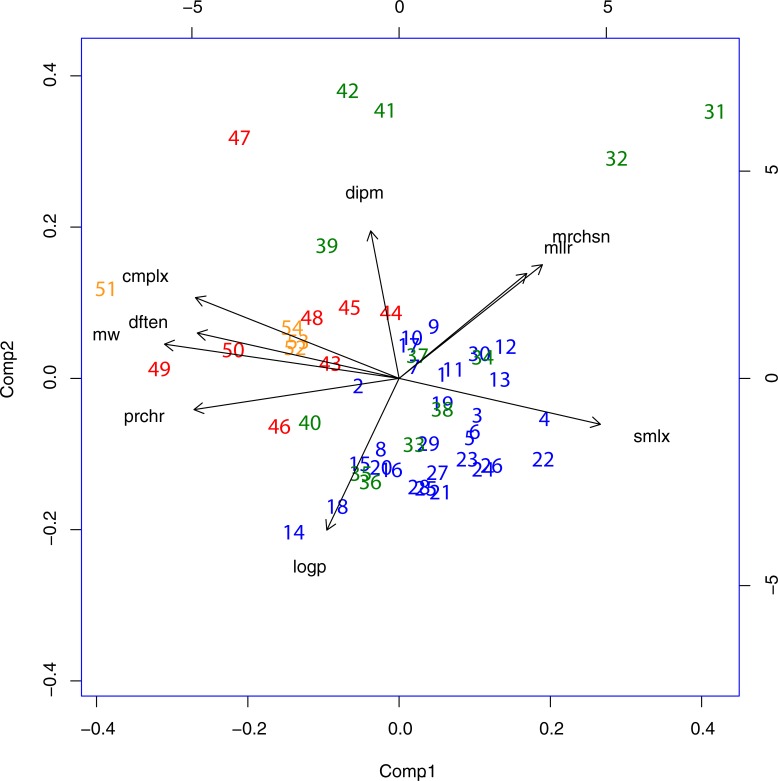
As in Fig 2 but with only Groups 1, 2 & 3.